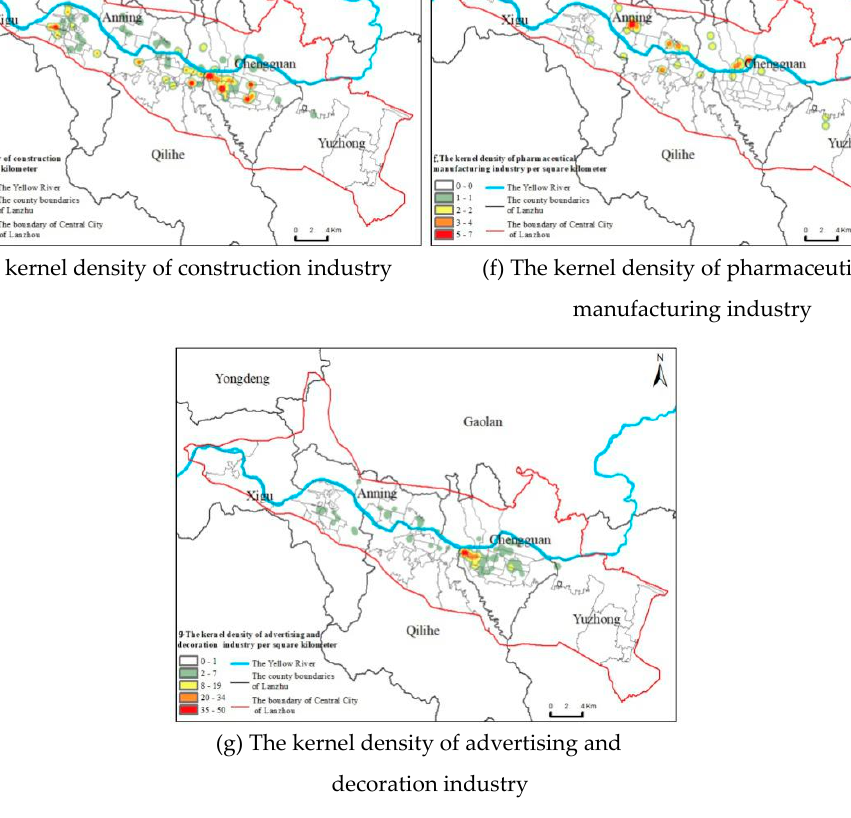
Figure 8. The kernel density distribution of different secondary industries .